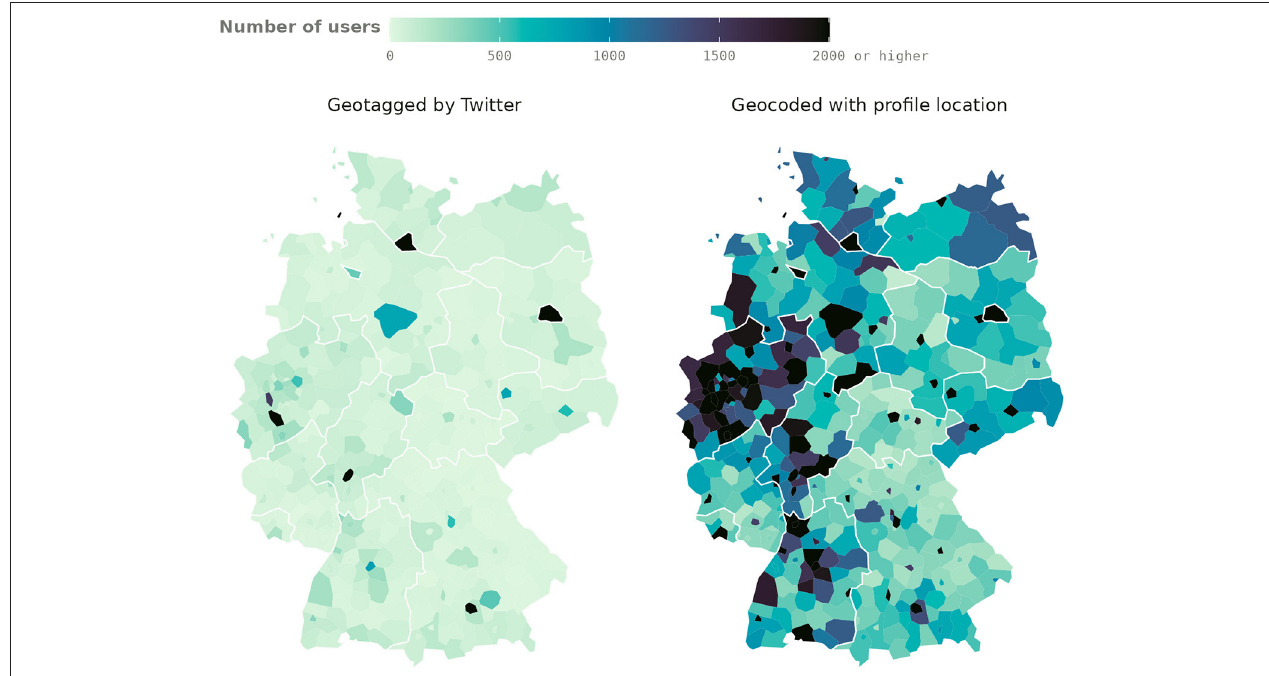
FIGURE 1 | Number of Twitter users who tweeted (retweets and tweets from verified accounts not included) between October 15, 2018, and October 14, 2021, per NUTS-3 region in Germany according to Twitter geotags and our geocoding results using user profile locations.